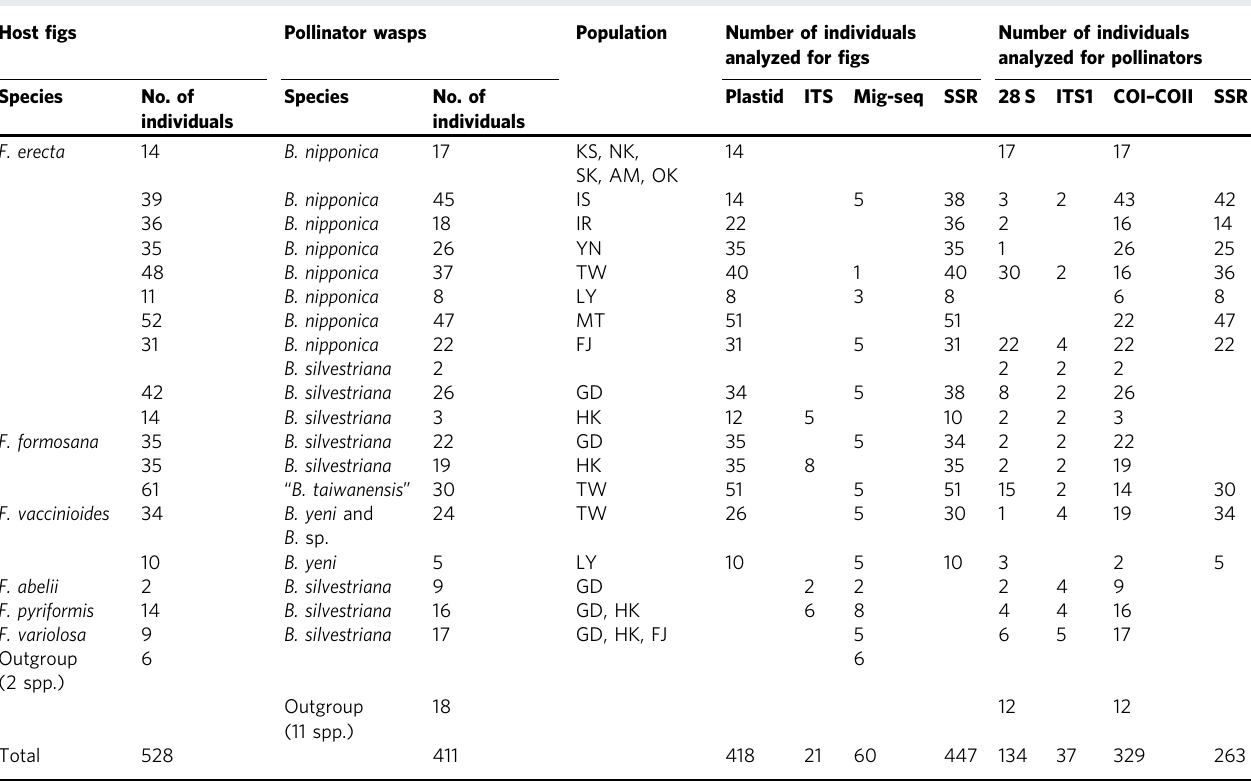
For abbreviations of population names, refer to Fig. 1; for detailed sample information, refer to Supplementary Data 1. The species names of fi gs and fi g wasps are shown in